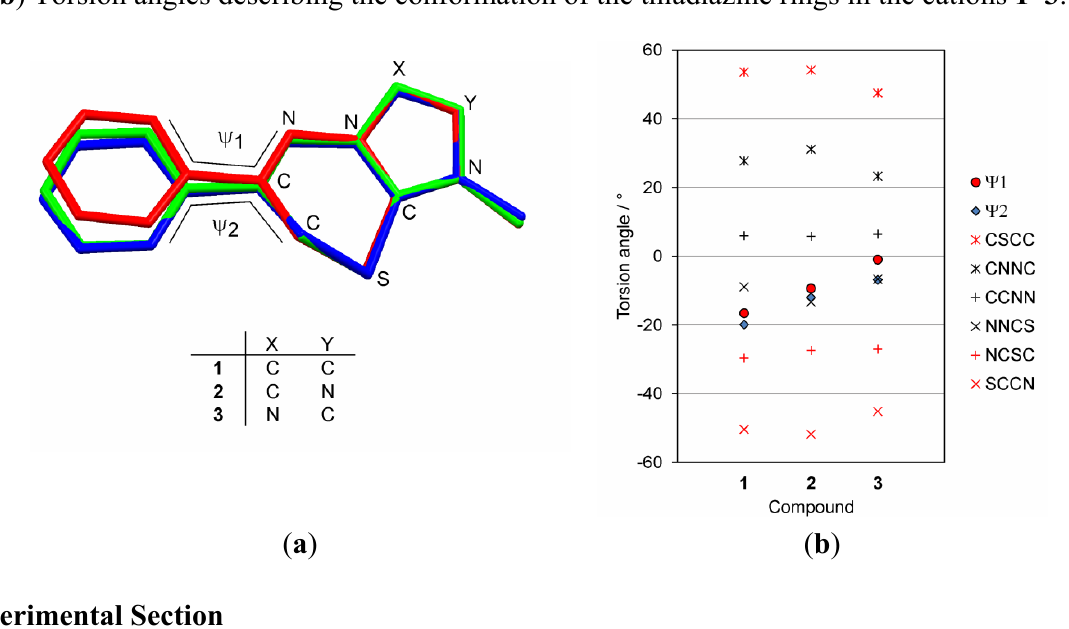
Figure 5. ( a ) Overlay of the 1,3,4-thiadiazinium cations of 1 (green), 2 (blue), and 3